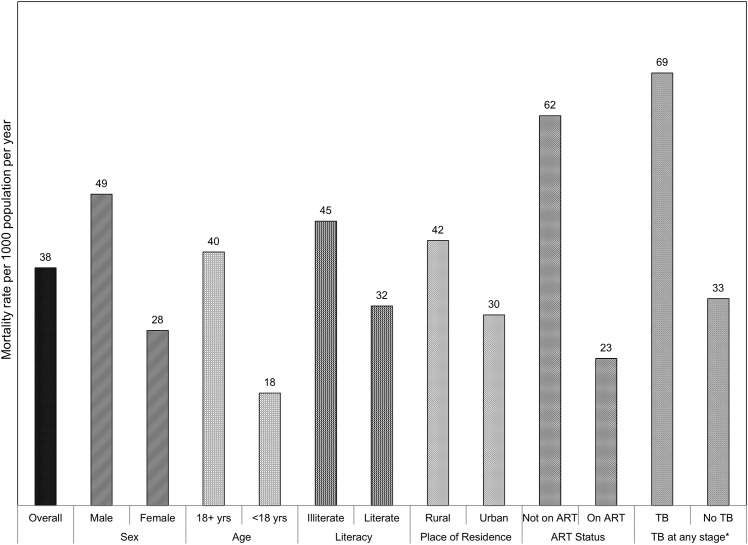
Mortality rates among PLHIV by selected background characteristics.The bar diagram demonstrates the estimated mortality rates among PLHIV per 1000 population per year. The estimated mortality rates are also disagreegated by sex of the PLHIV, their age, literacy, place of residence, ART status and presence of co-infection like TB at any stage. TB at any stage is defined as ever had TB since tested positive and last contact prior to end of intervention.